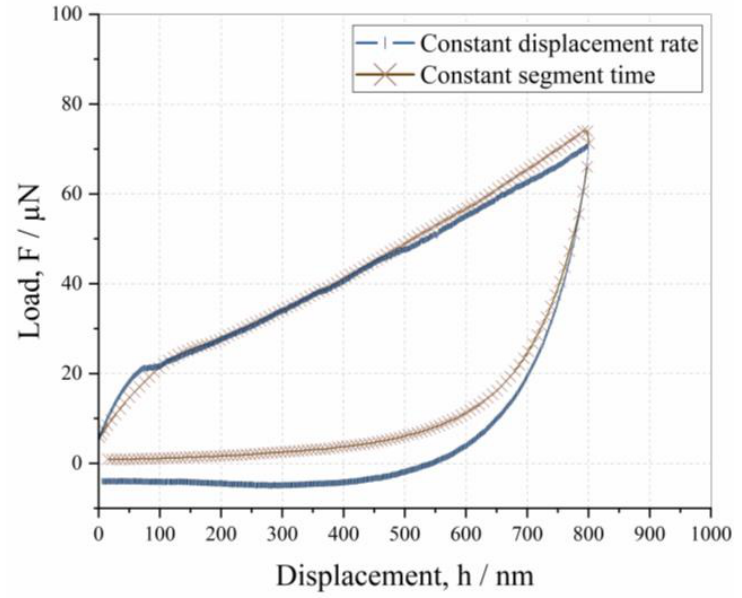
Figure 7. Comparison of representative force–displacement curves of prismatic crystal faces at slow (180 nm/s, constant displacement rate) and fast (1273 nm/s, constant segment time) displacement rates at a penetration depth of 800 nm.